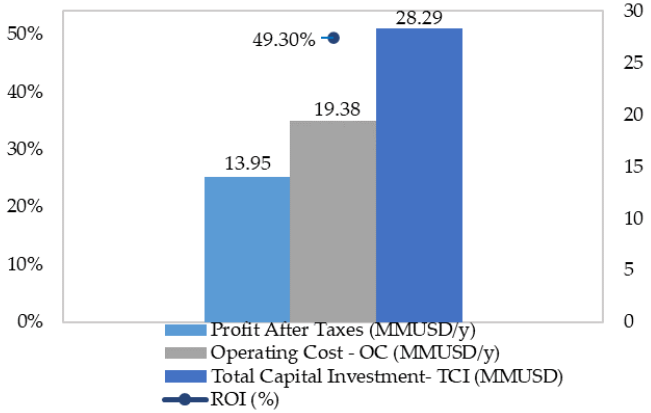
Figure 4. Summary of economic evaluation results for the crude oil production process, adapted from [12].